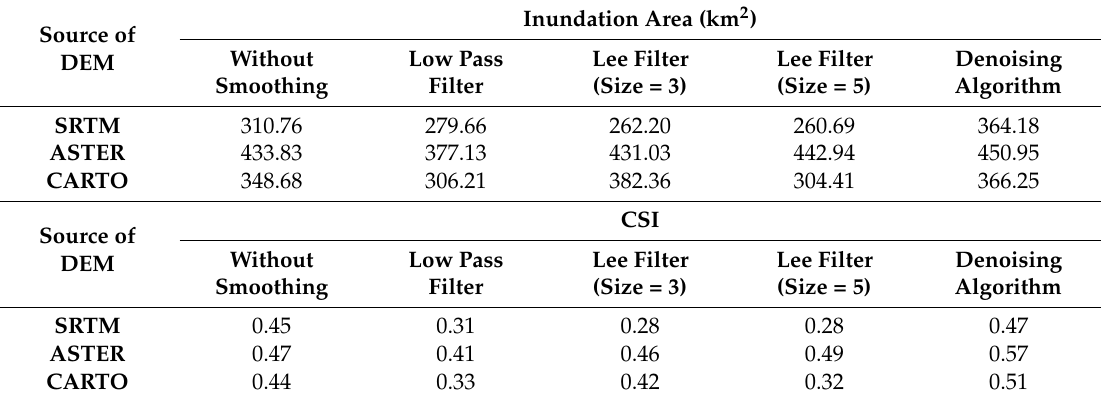
Table 3. Comparison of simulated flood extent using the Moderate Imaging Spectroradiometer (MODIS) imagery for the 2008